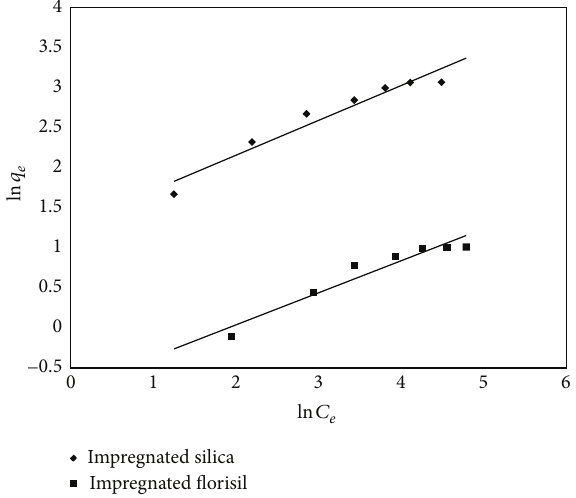
Figure 12: Freundlich isotherm for As(V) adsorption on impreg- nated silica and